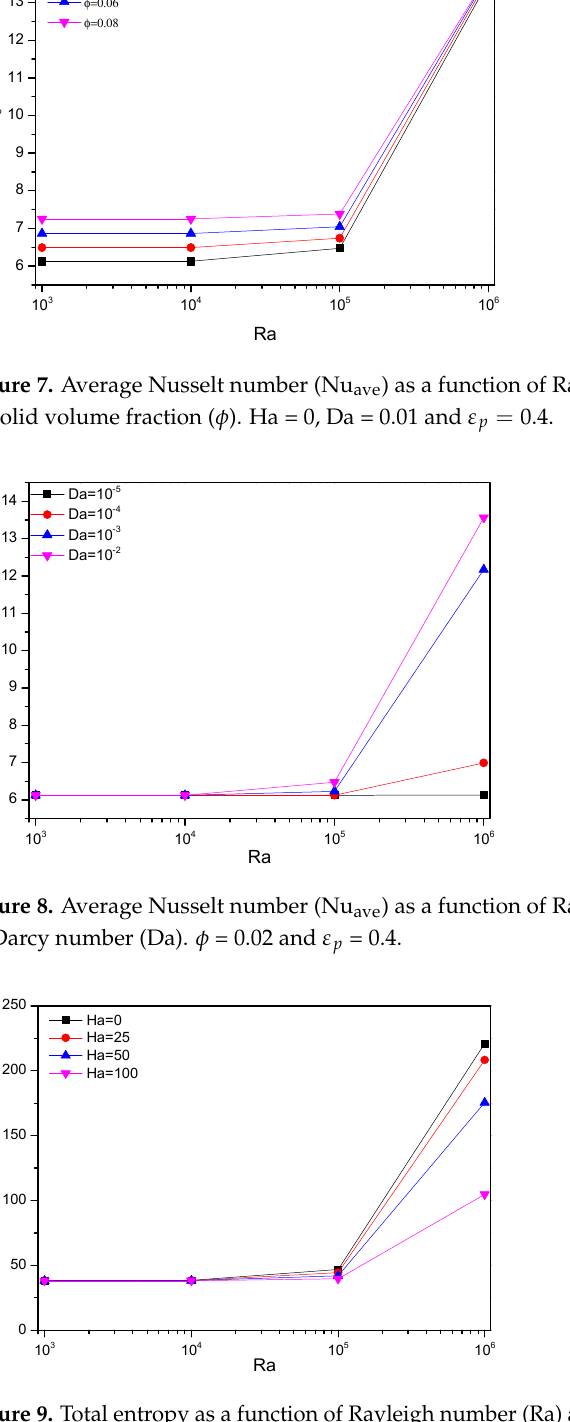
Figure 9. Total entropy as a function of Rayleigh number (Ra) at various values of Hartmann number (Ha). Da = 0.01, φ = 0.02 and ε p = 0.4 .